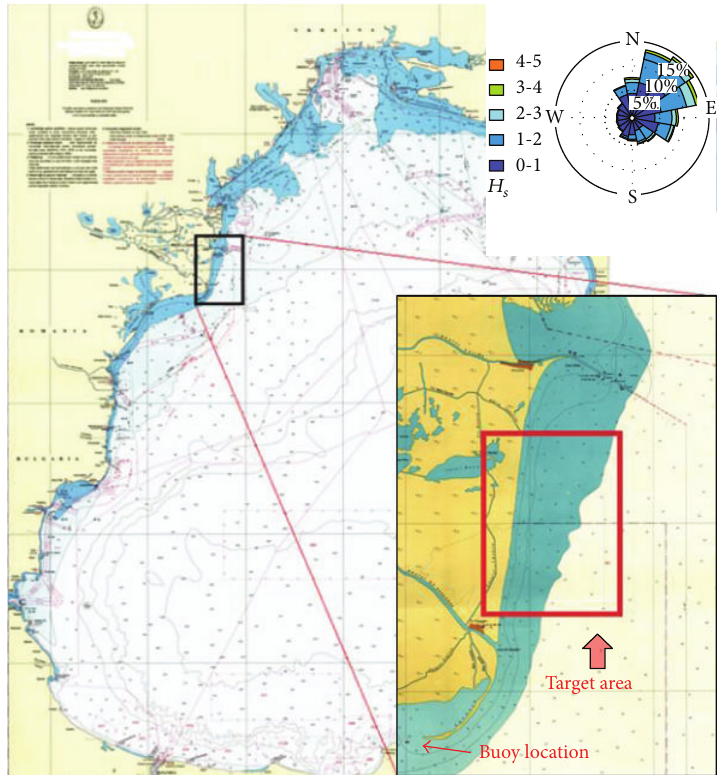
Figure 1: Location of the target area and the wave conditions resulting from an analysis of 5 years of data (2006–2011).